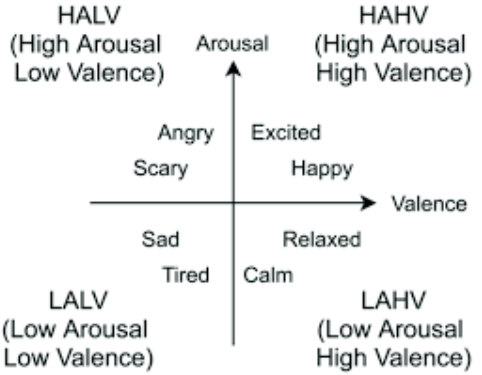
Figure 3. Arousal–valence model for emotion representation.